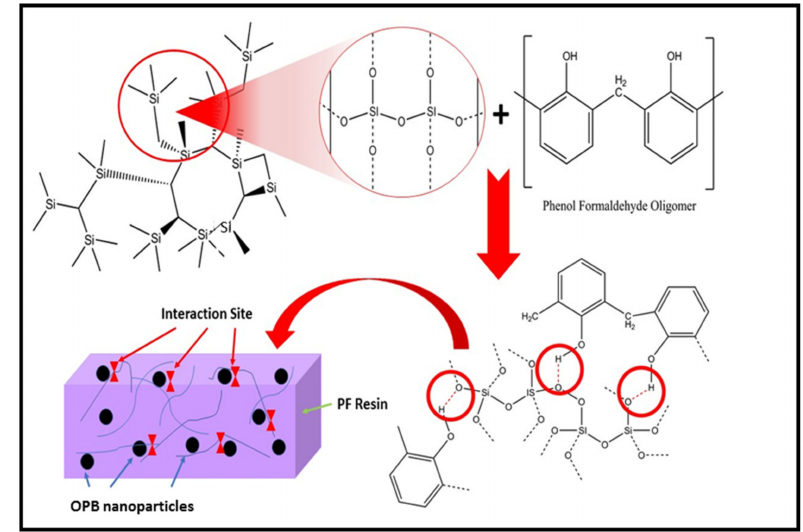
Figure 4. Hydrogen bonding mechanism of PF nanocomposite-filled OPB